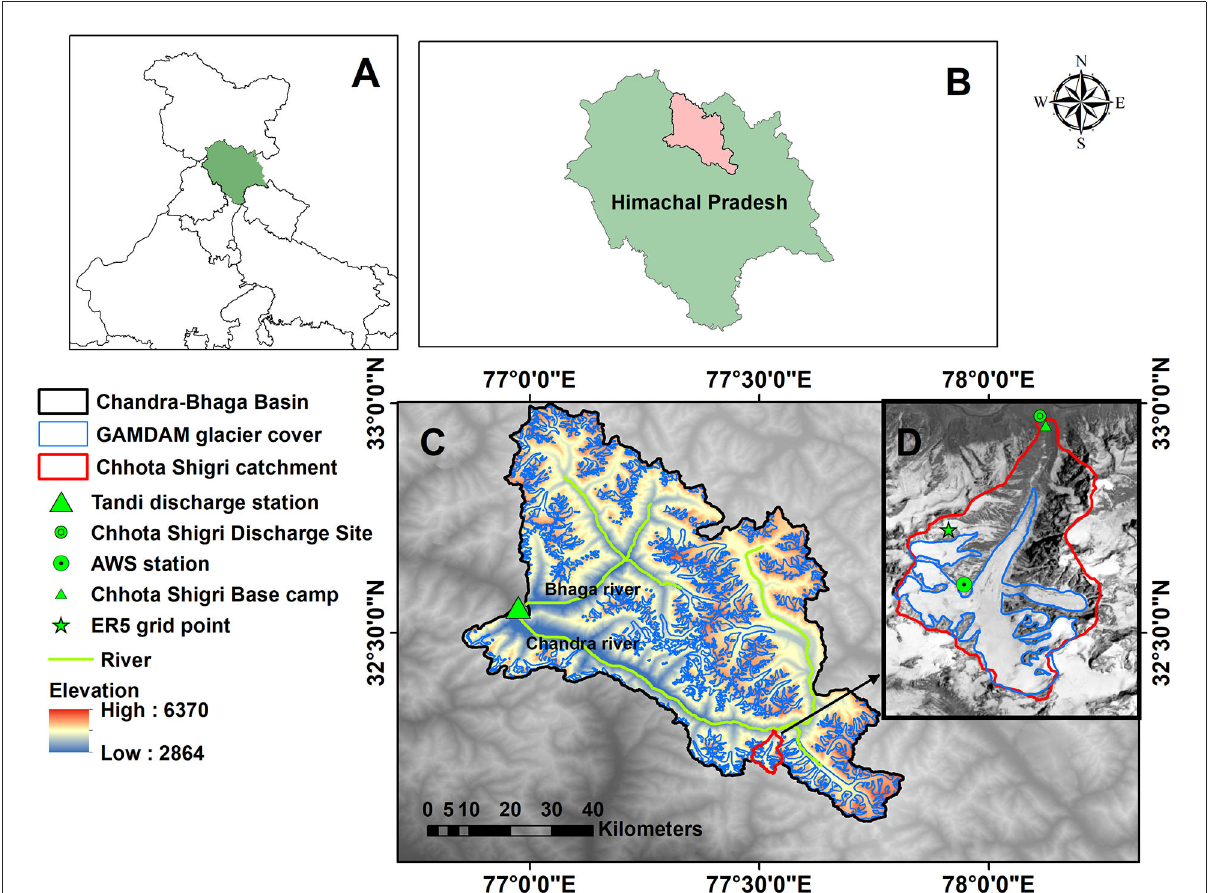
FIGURE1 Location map of Chandra-Bhaga Basin (A–C) , Basin boundary (black) with Tandi discharge site (green), river (green), and GAMDAM glacier cover (blue). Inset is the map of Chhota Shigri Catchment (D) with the catchment outline (red), Chhota Shigri Glacier (blue), and location of AWS station, discharge site, Chhota Shigri base camp, and ERA5 grid point (green